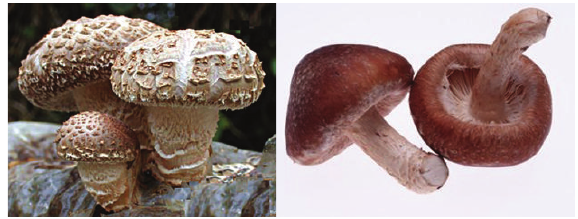
Figure 2: Lentinus edodes or “shiitake